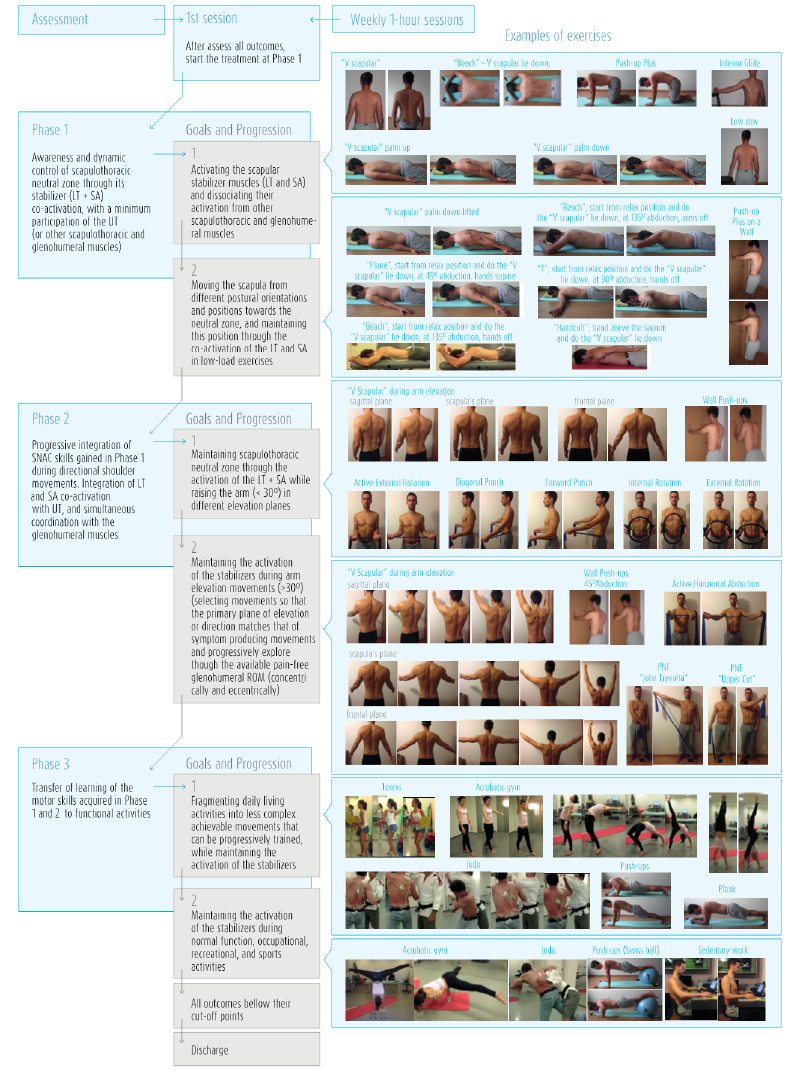
Figure A3. Scapular-focused treatment